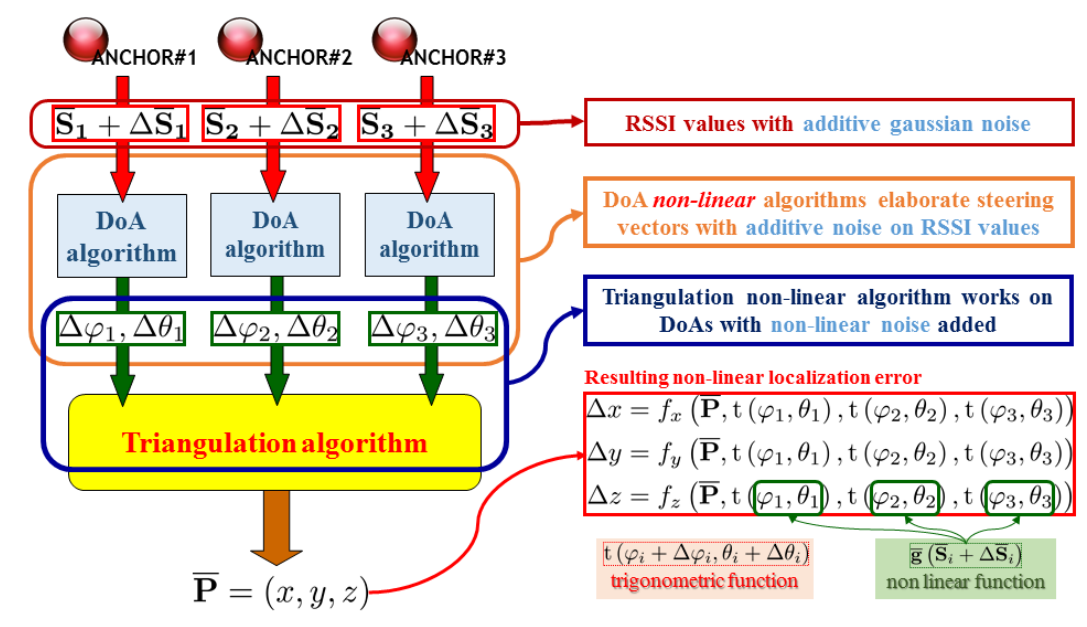
Figure 4. Error propagation scheme for RSSI Direction-of-Arrival (DoA) based localization.